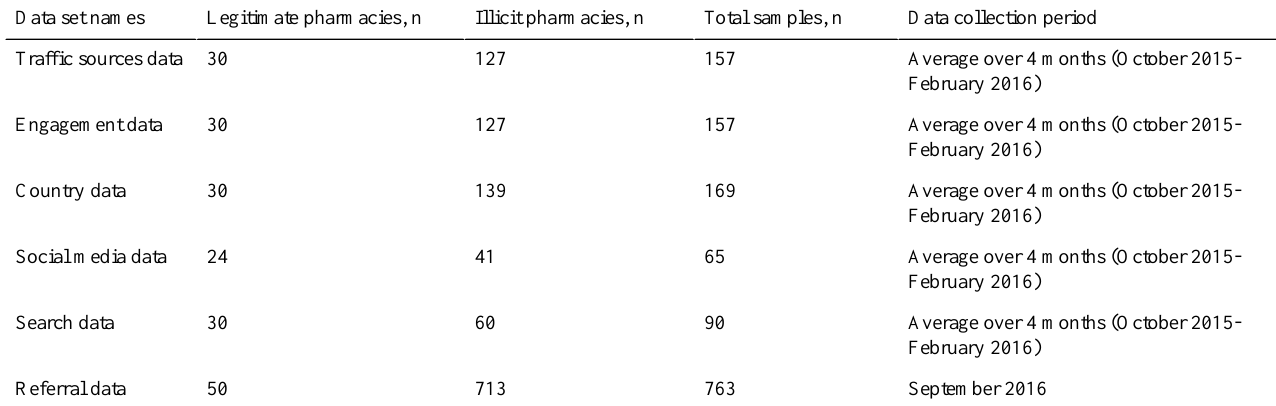
Table 1. Data sets and sample size.